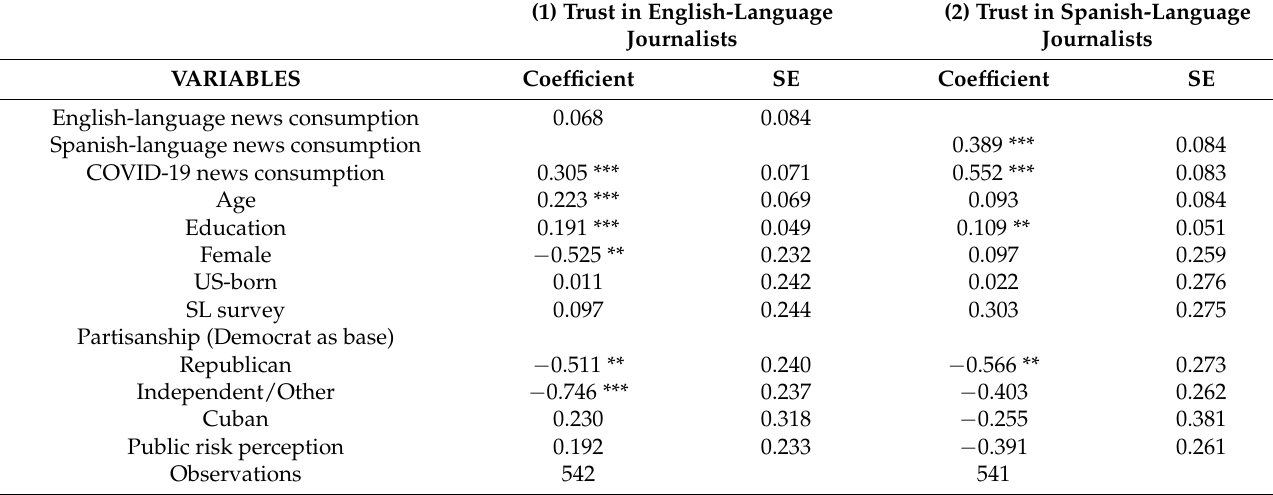
Table 1. KRLS models predicting source credibility in English- and Spanish-language journalists. (1) Trust in English-Language (2) Trust in Journalists